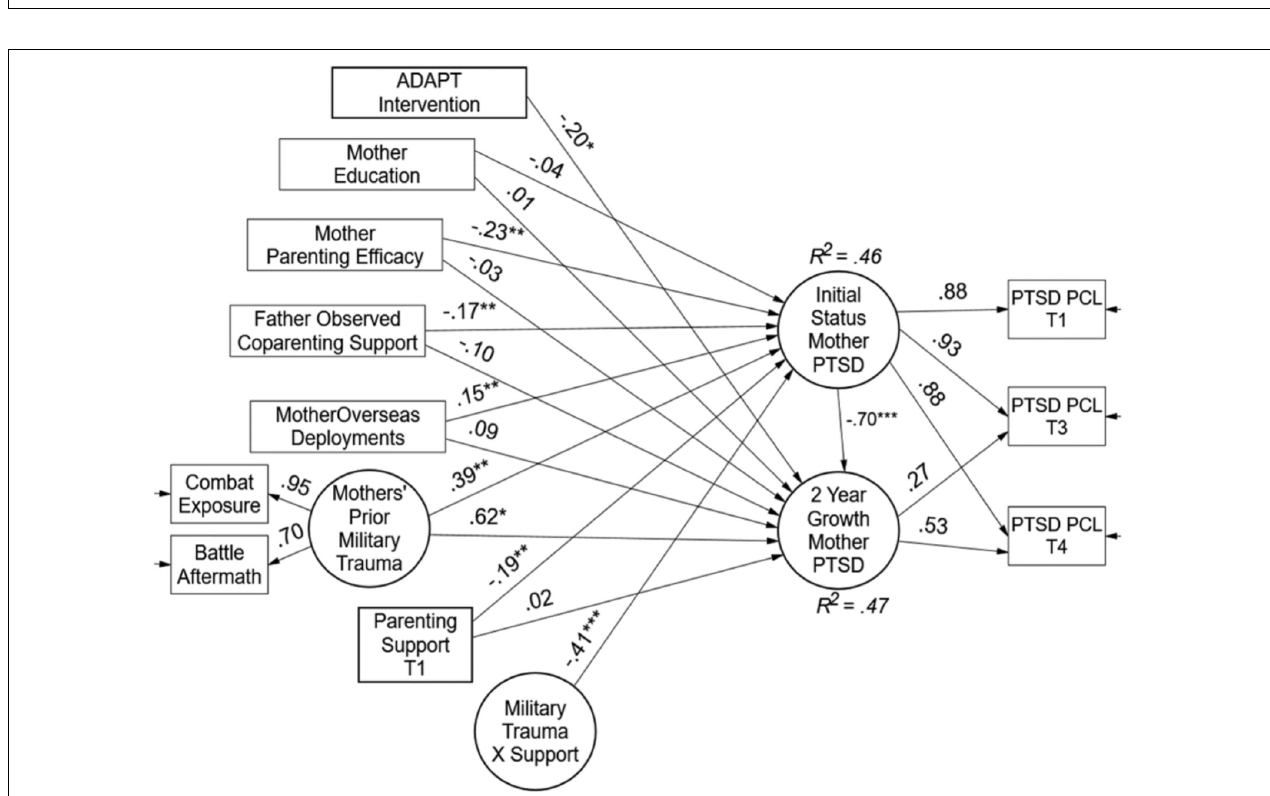
FIGURE 5 | Test of recovery capital model for military mothers. Paths are standardized coefficients [free parameters = 28; –2 LL = –2871.27; Akaike Information Criteria (AIC) = 5798.55; and Bayesian Information Criteria (BIC) =